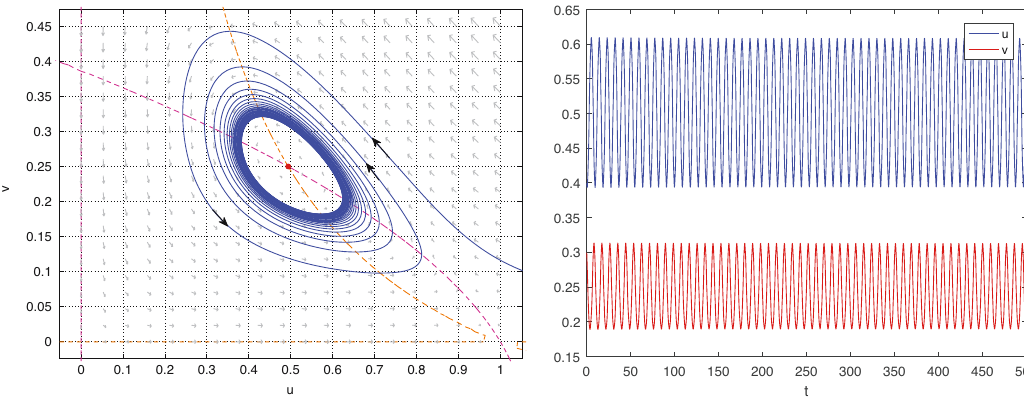
( ) 3 −1 , 1 is locally stable, where = < a a 3 0 . 3 3